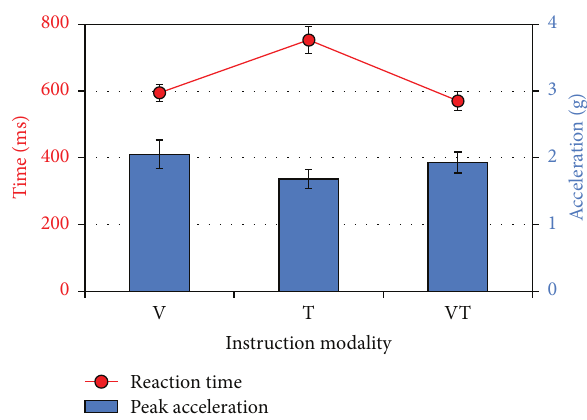
Figure 3: Mean RTs and mean peak accelerations of knee lifts in visual (V), tactile (T), and visual-tactile (VT) modality conditions. Error bars represent SEMs.